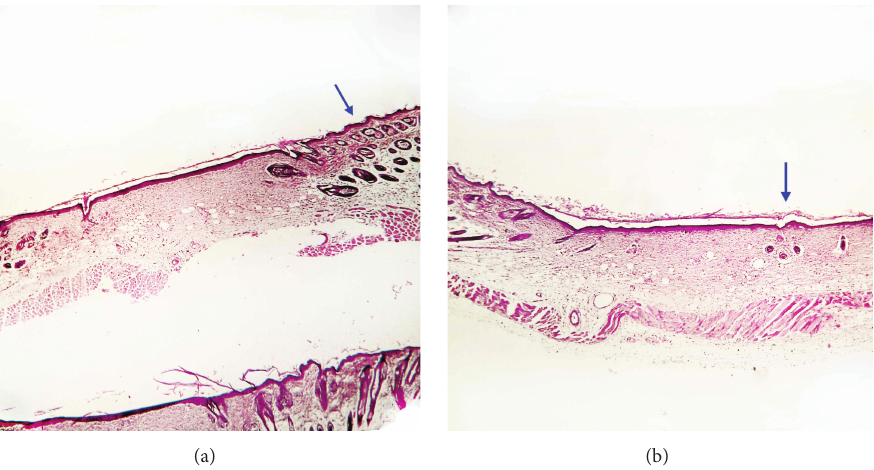
Figure 3: Photomicrographs of skin in emu oil (a) and control (b) groups in the 14th day. Thickness measure of epidermis in the margin of the wound and the number of hair follicles on the edge of the wound were higher in the Emu oil treated group in comparison with control group. Staining: Hematoxylin-Eosin, magnification: